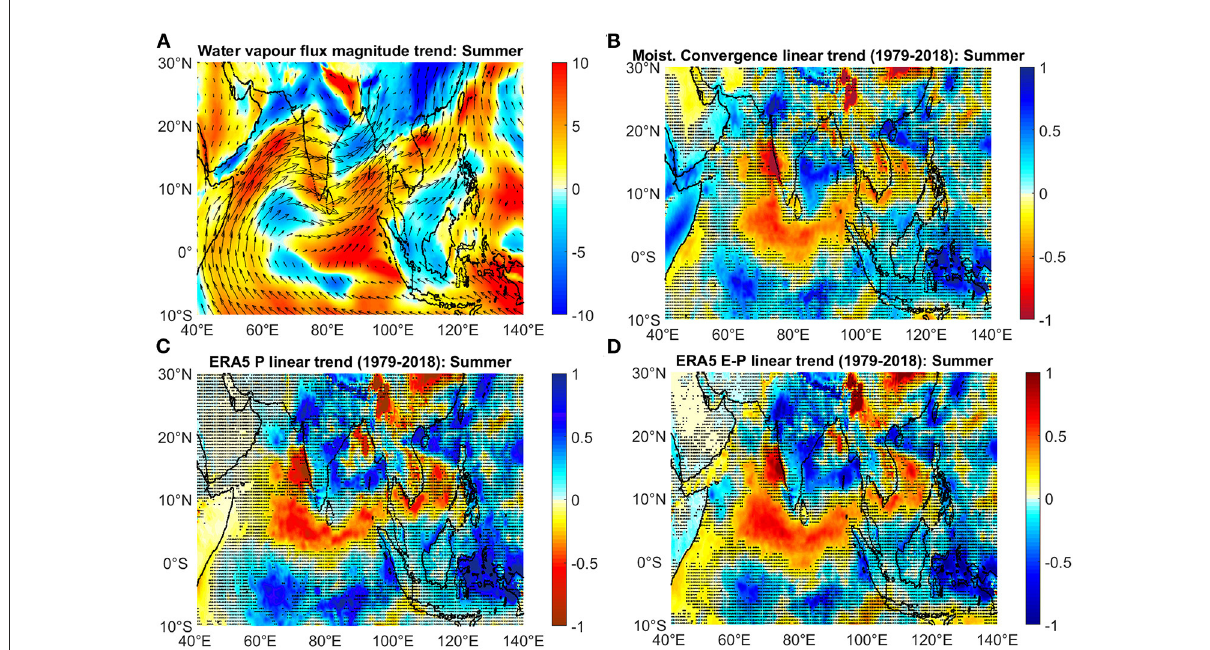
FIGURE9 ERA5 summer (JJA) linear trends (1979–2018) in (A) Magnitude of vertically integrated atmospheric water vapor transport (kg m − 1 s − 1 /dec). The climatological summer mean atmospheric water vapor transport (vectors, kg m − 1 s − 1 ) is also depicted. (B) Moisture transport convergence (mm/day/dec.); (C) Precipitation (mm/day/dec.); (D) Evaporation minus Precipitation (mm/day/dec.). Regions where the linear trend is not significant at the 95% confidence interval are